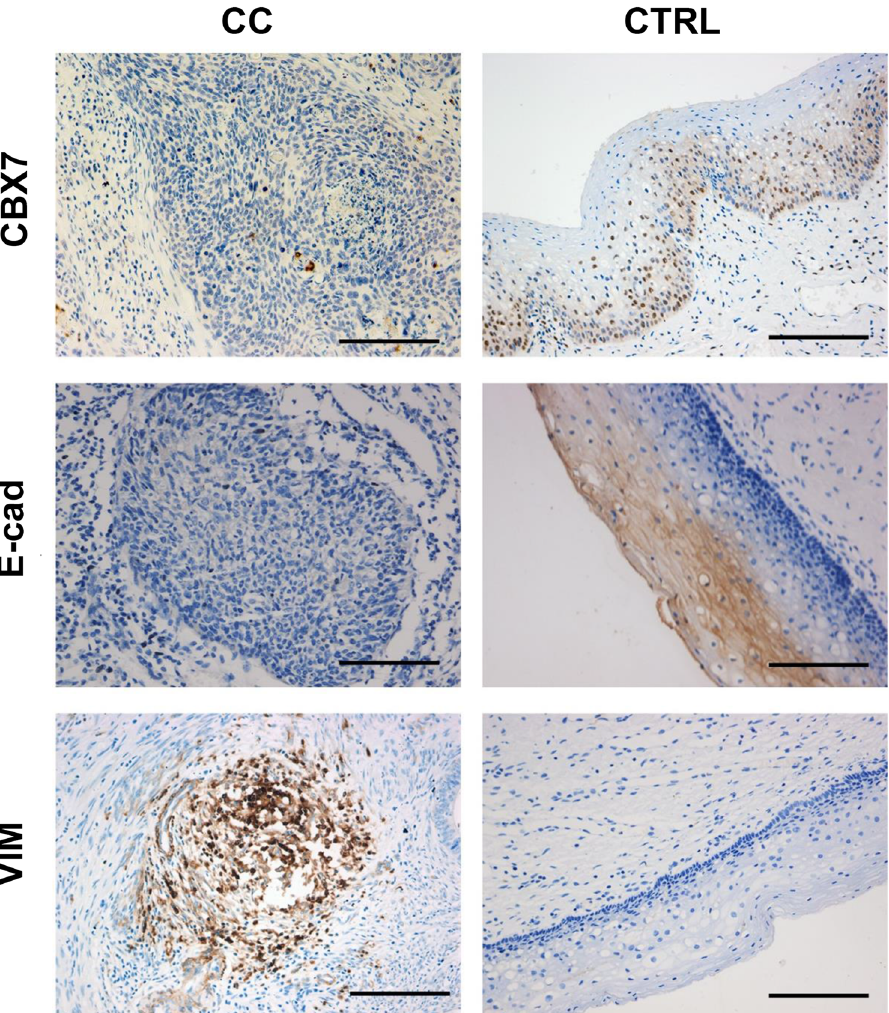
Figure 2: IHC staining. IHC staining was performed to detect the expression of CBX7, E - cad, and VIM in the CC and adjacent normal cervical tissue samples. Scale bar, 10